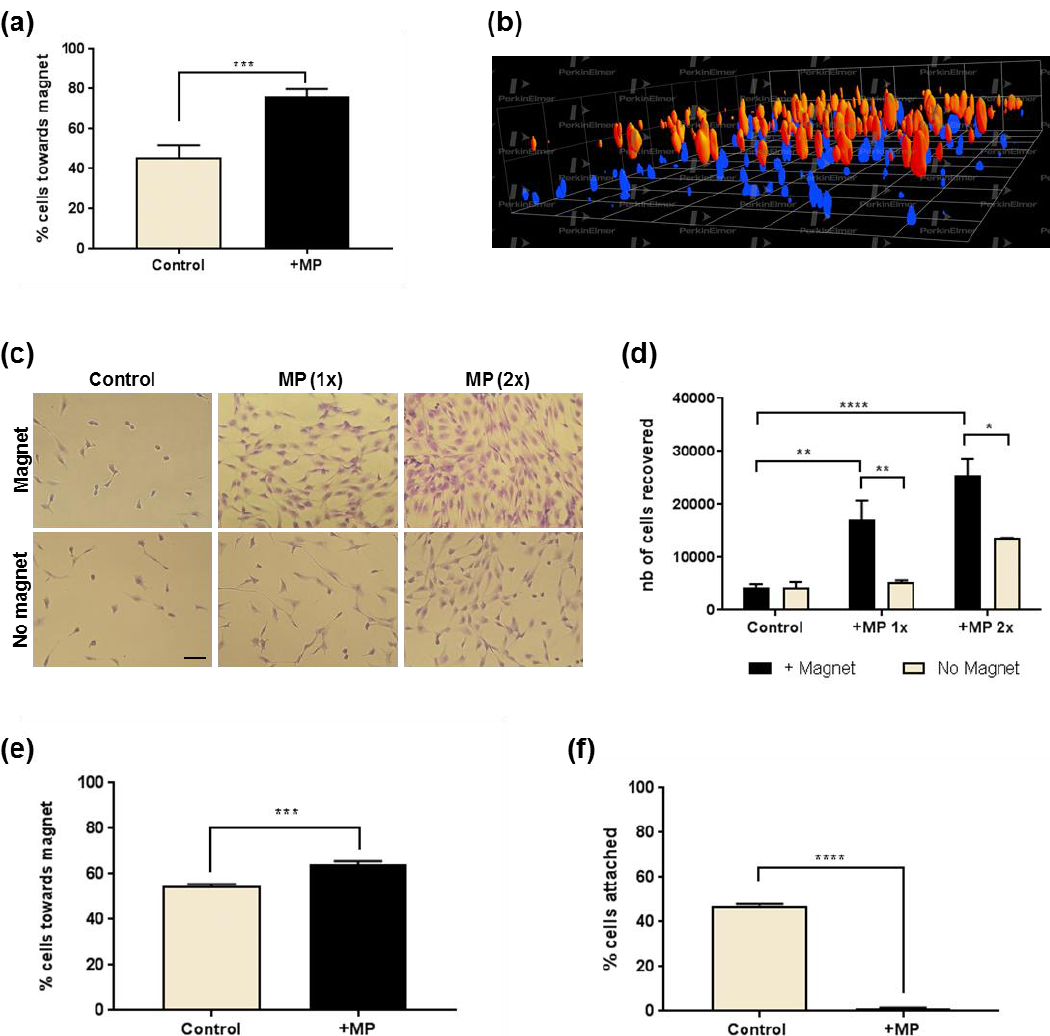
Figure 3. Magnetically assisted MSC migration in culture environments. ( a ) 2D cell migration of unloaded or MP-loaded cell populations exposed to a magnet located under the culture plate laterally to the field of view, presented as the proportion of cells showing net cell movement towards the magnet side. ( b ) Confocal imaging of cell distribution of labelled (blue) or unlabelled (red) cells seeded on a 200 µ m porous membrane and exposed to magnet presence for 72 h. ( c ) Migration of MSCs in a 3D hydrogel in the presence of MPs. Toluidine blue staining of adherent MSCs recruited at the bottom of the plate after migration through a gel after 24 h in the presence or absence of a magnet located underneath the well. Bar = 100 µ m. ( d ) Corresponding metabolic activity measurement of adherent MSCs loaded with 10 µ g / mL (1 × ) or 20 µ g / mL (2 × ) MP dose and recovered after migration through a gel in the presence (white) or absence (black) of a magnet positioned underneath the well. ( e , f ) E ff ect of a magnet located on the side of the well containing MSCs seeded in a gel, with or without MP loading, showing the percentage of cells displaying a move towards the magnet side ( e ), and the percentage of cells reaching the base of the well ( f ). * p < 0.05, ** p < 0.01, *** p < 0.001 and **** p <